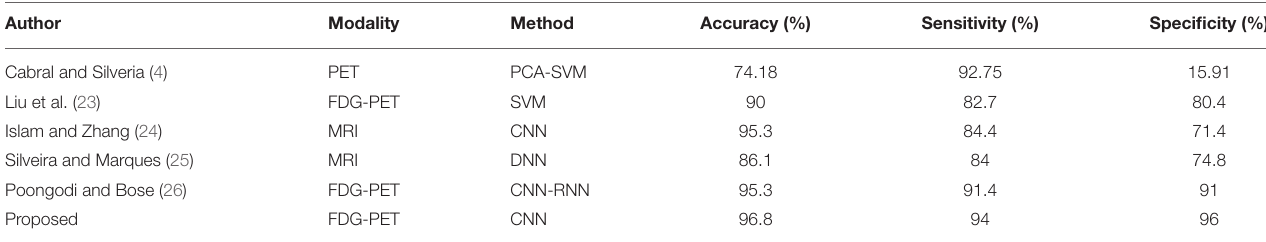
TABLE 3 | Performance comparison of the proposed system with existing